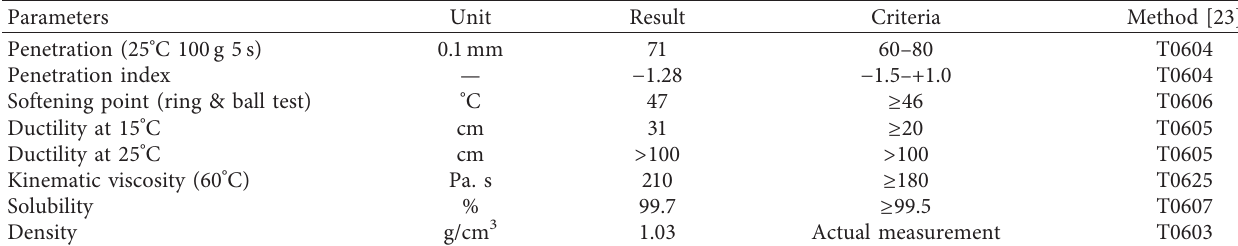
Table 1: Test indices of 70# neat asphalt binder.